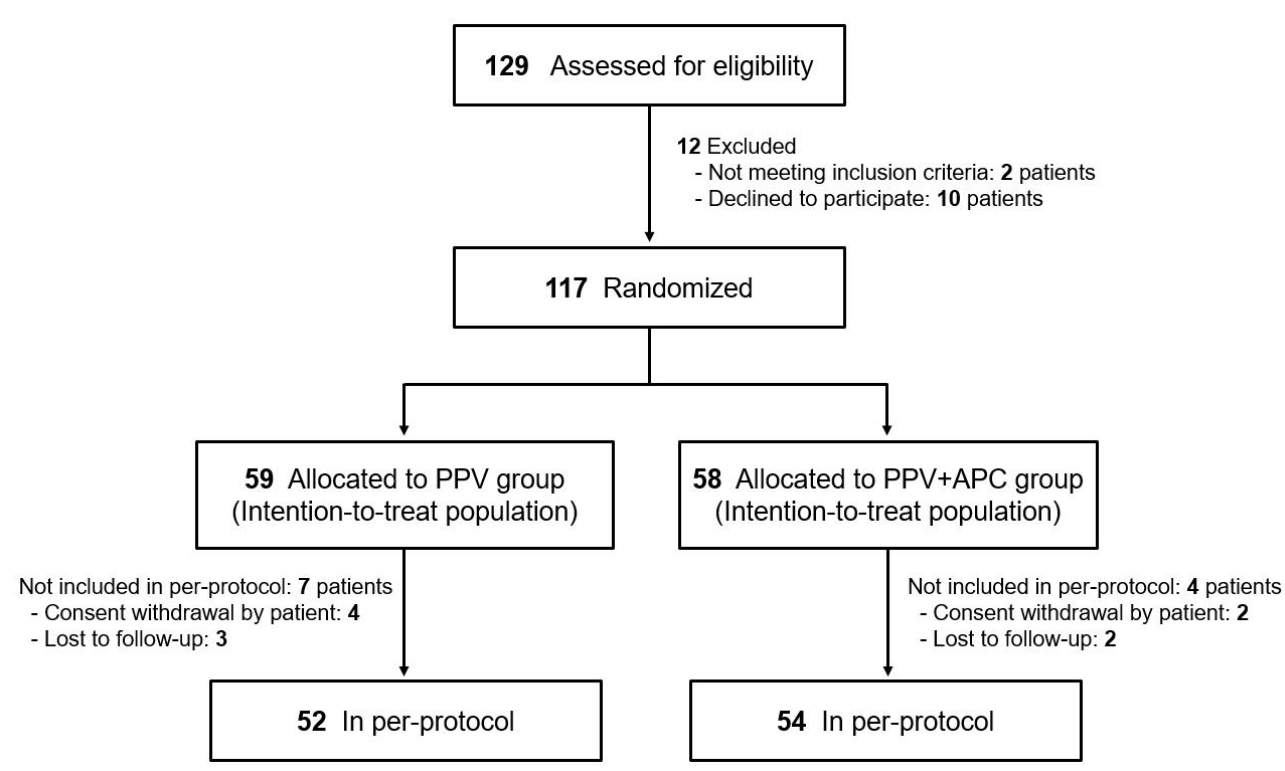
Figure 1. Flowchart of randomization and follow-up for the study (CONSORT flow diagram).